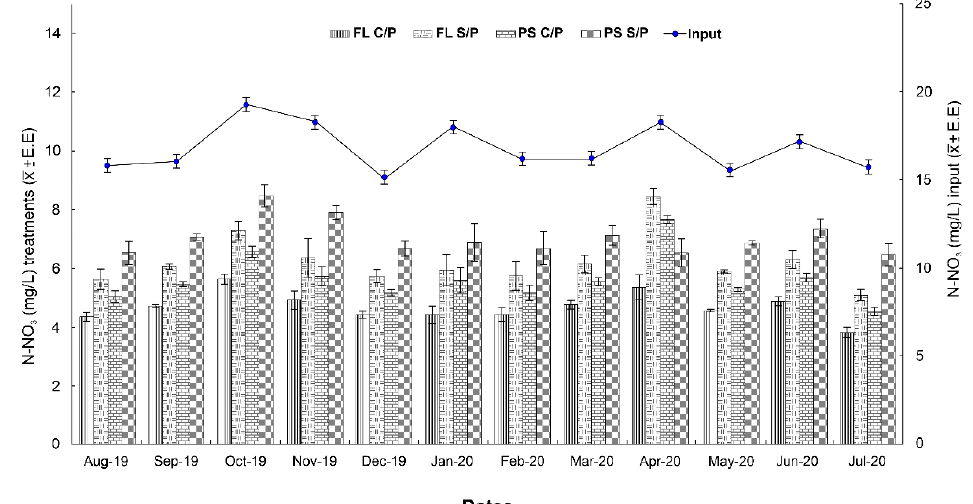
Figure 11. Average N-NO 3 concentrations (±E.E.) during the experiment. (FLCP: free flow with plant; FLSP: free flow without plant; PSCP: saturated flow with plant; PSSP: saturated flow with plant; E.E.: standard error).